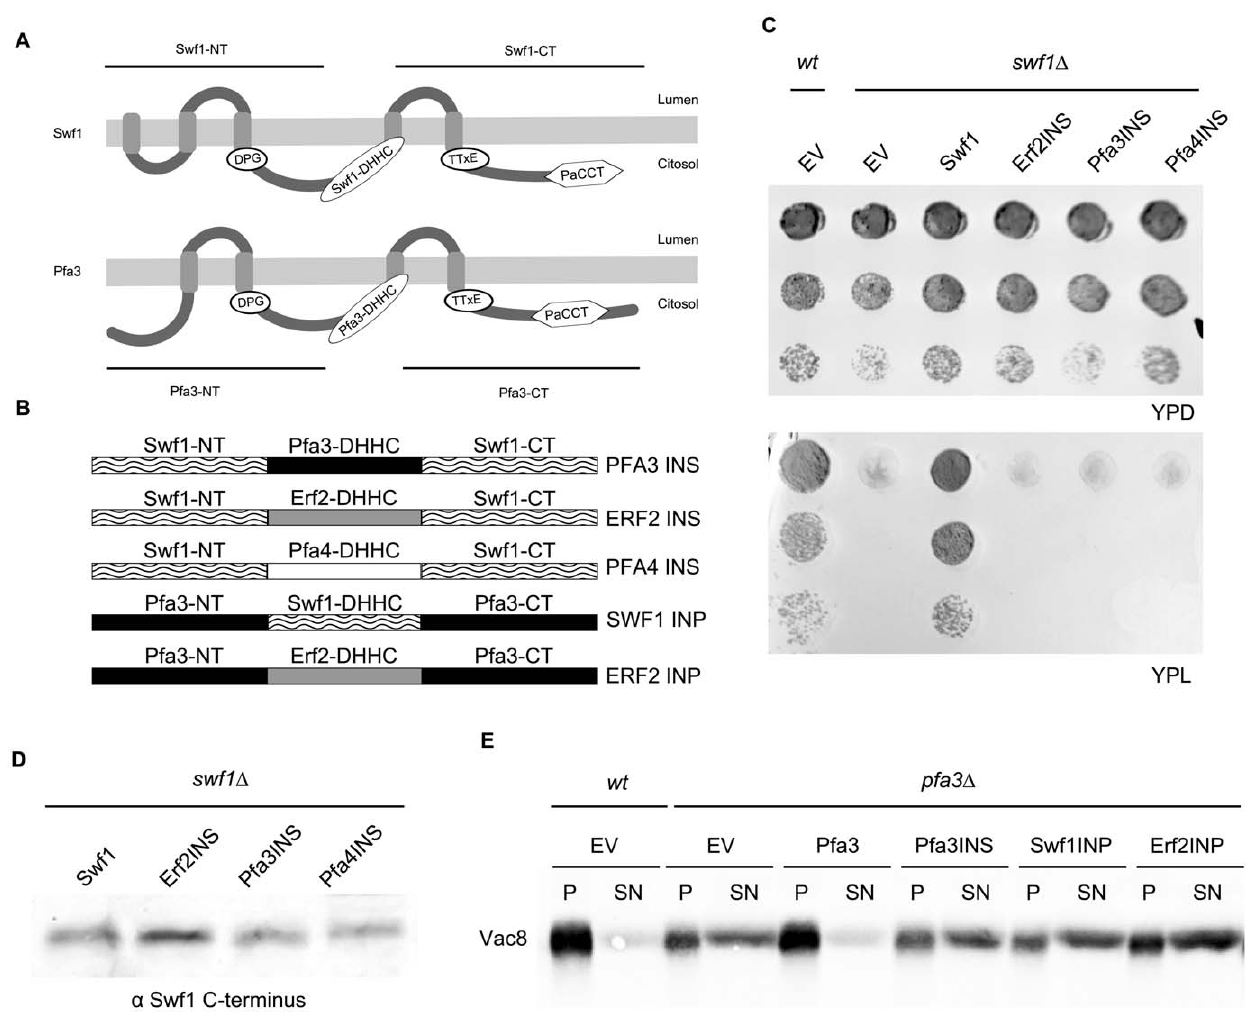
Figure 5. DHHC domain swapping analyses. A. Schematic representation of Swf1 and Pfa3 transmembrane topology, indicating N-terminal, DHHC and C-terminal regions used in DHHC domain swapping experiments. B. Schematic representation of the chimeric proteins used in subsequent experiments. C. Serial dilutions of a swf1 D strain transformed with wt Swf1, or with Swf1 chimeras containing the DHHC domains from Erf2 (Erf2INS), Pfa3 (Pfa3INS) and Pfa4 (Pfa4INS). Transformants were grown in solid rich medium containing glucose (YPD, upper panel) or in medium containing lactate as the sole carbon source (YPL, lower panel). D. Western blot analysis of Swf1 and the chimeras containing the different PATs’ DHHC domains were developed using anti-Swf1 C-terminus antibodies to evaluate expression levels. E. Subcelullar fractionation assay to evaluate the membrane association of Vac8 and hence, pfa3 D strain complementation by DHHC-swapped, chimeric genes.